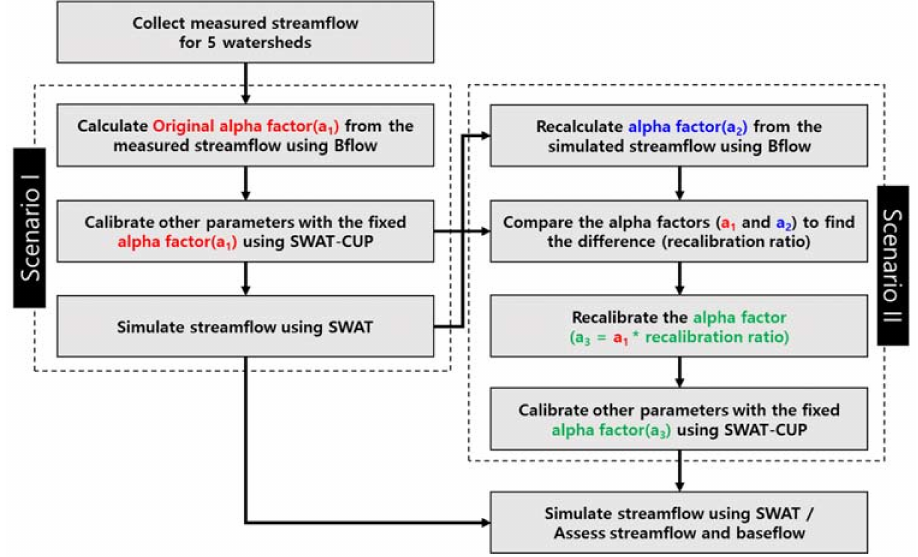
Figure 4. SWAT application procedure for accurate prediction of hydrograph